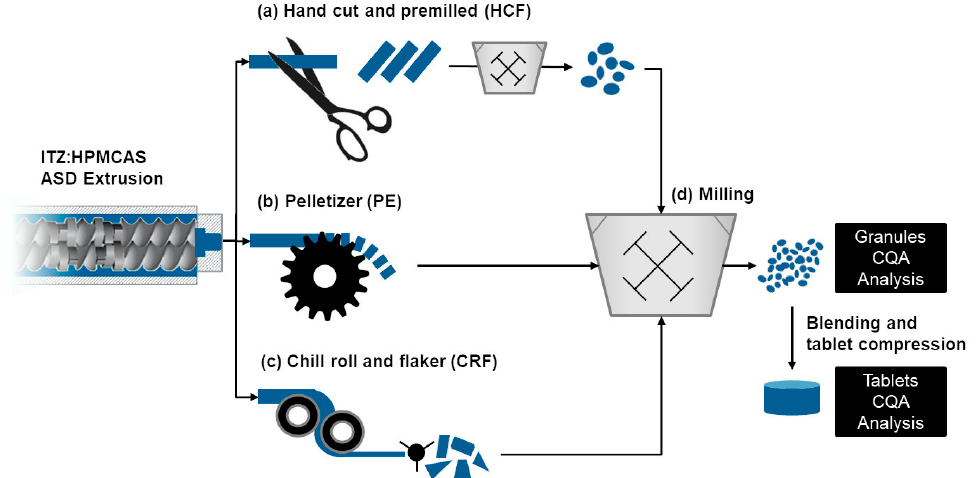
Figure 1. Downstream processing of extruded strands by hand-cutting ( a ), pelletizing ( b ), and chill roll technology ( c ) and subsequent milling ( d ).